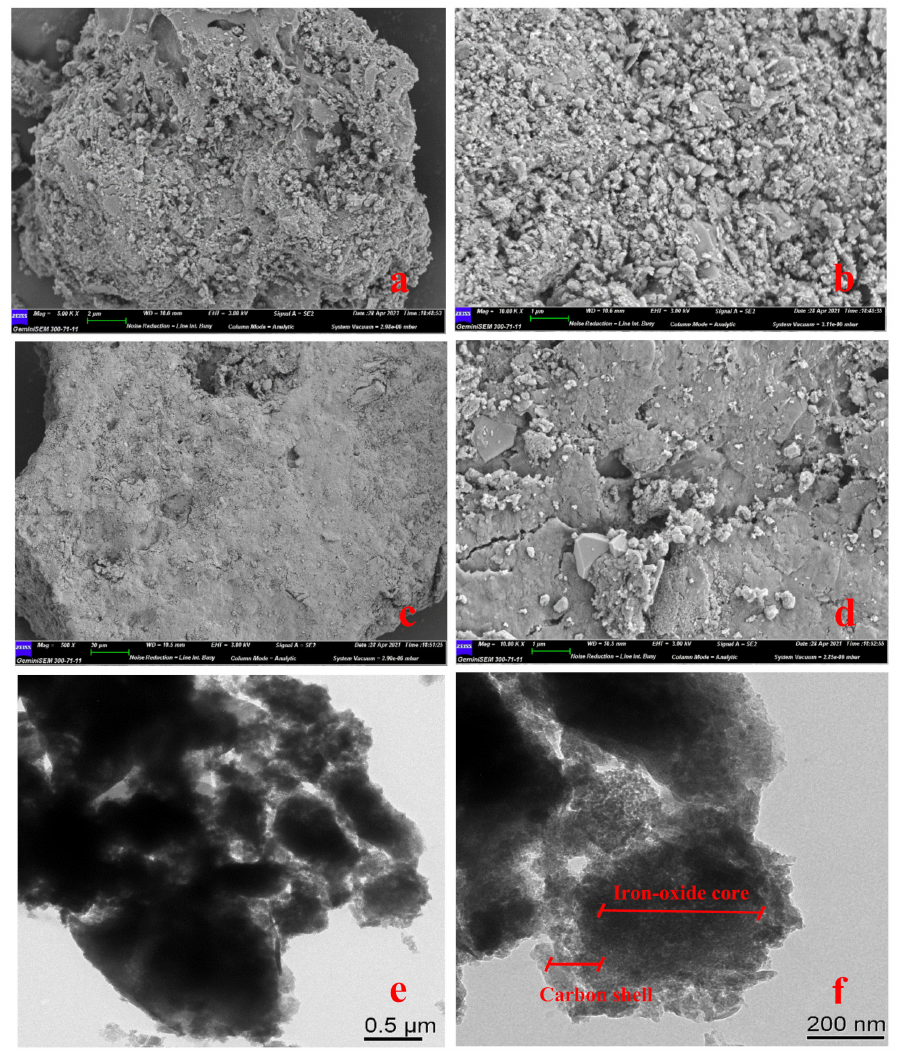
Figure 3. ( a , b ) SEM images of BC; ( c , d ) SEM images of SMB; ( e , f ) TEM images of SMB. Magnetic separation capacity is very important for the separation and recovery of adsorbents. The magnetic properties of SMB were measured by the VSM experiment. From the hysteresis loop of Figure 4, the saturation magnetization (Ms), the magnetic remanence (Mr), and the coercivity (Hc) values were 25.60 emu · g − 1 , 6.10 emu · g − 1 , and 205.20 Oe, respectively. The saturation magnetization was significantly lower than the ferromagnetism of Fe 3 O 4 (90 emu · g − 1 ) [44]. The reason for this phenomenon may